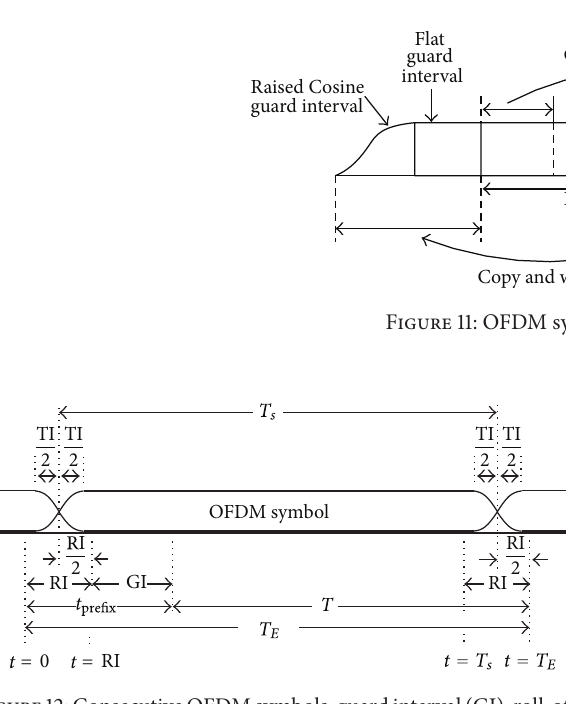
Figure12:ConsecutiveOFDMsymbols,guardinterval(GI),roll-off interval (RI), and windowing.